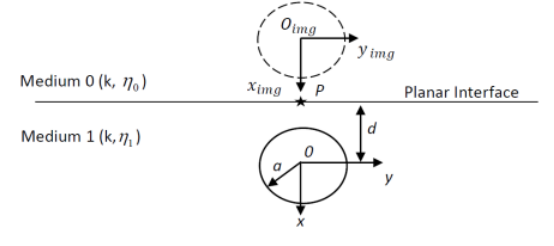
Figure 2: Buried PEMC circular cylinder in the lower half- space and its image in the upper